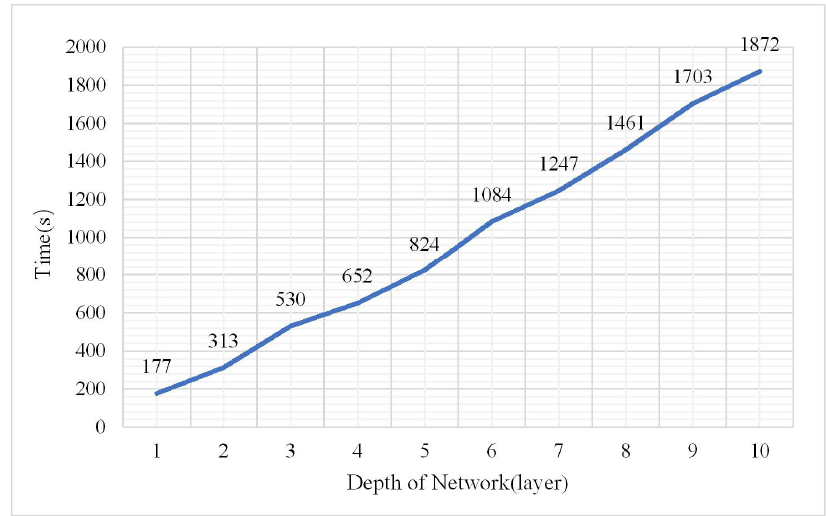
Figure 6. Change in training time.